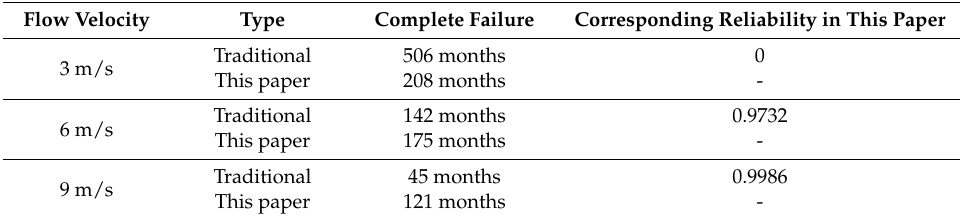
Table 5. Comparison results of the two methods.